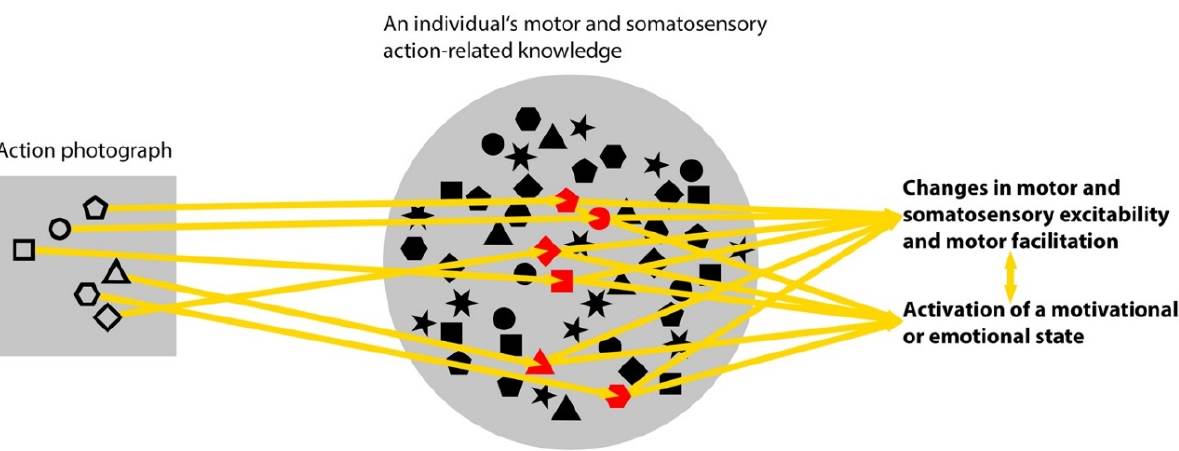
Figure 2. Schematic illustration of the relationship between the representational characteristics of action photos and outcomes of their cognitive processing in the AON. Note . The small, differently shaped objects stand for action elements. These elements relate to movements of body parts, the motor control of muscle activities, somatosensory processes or sensations, action-related objects or contexts, goals, and emotional value. An arrow means “evokes.” The color red signifies “activation”.